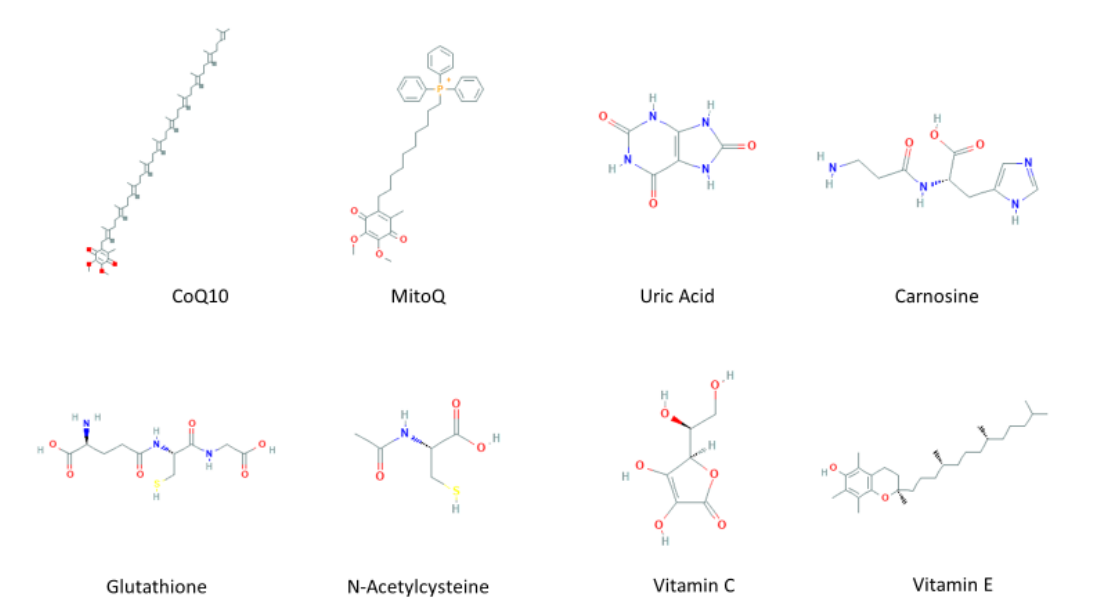
Figure 2. Molecular structures of non-enzymatic antioxidants.